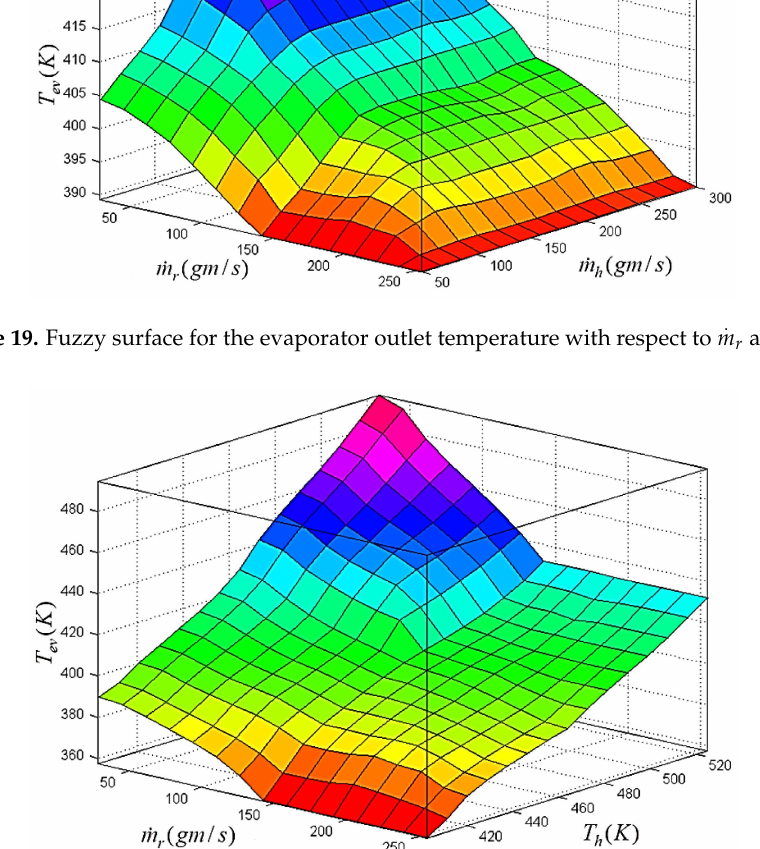
Figure 20. Fuzzy surface for the evaporator outlet temperature with respect to